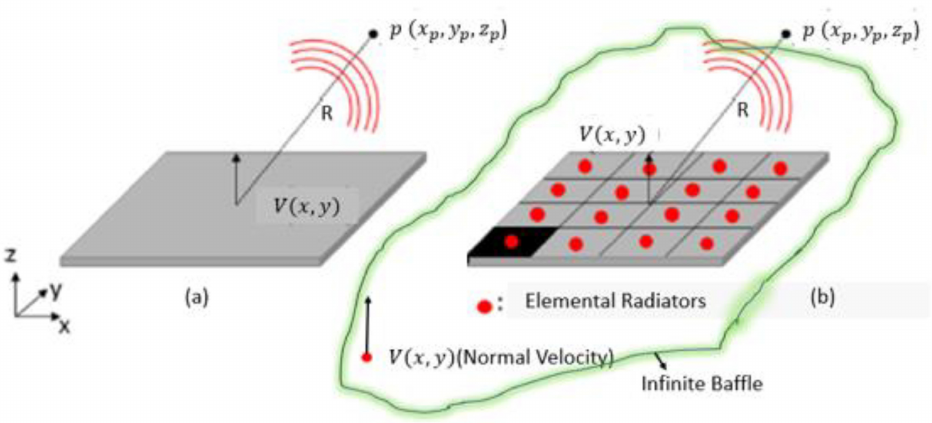
Figure 2. Schematic diagram of elemental